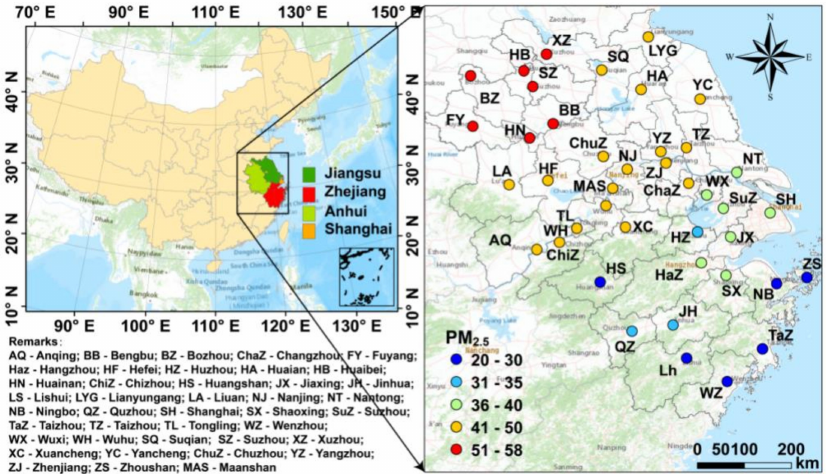
Figure 1. Geographic location of the Yangtze River Delta region and its prefecture-level